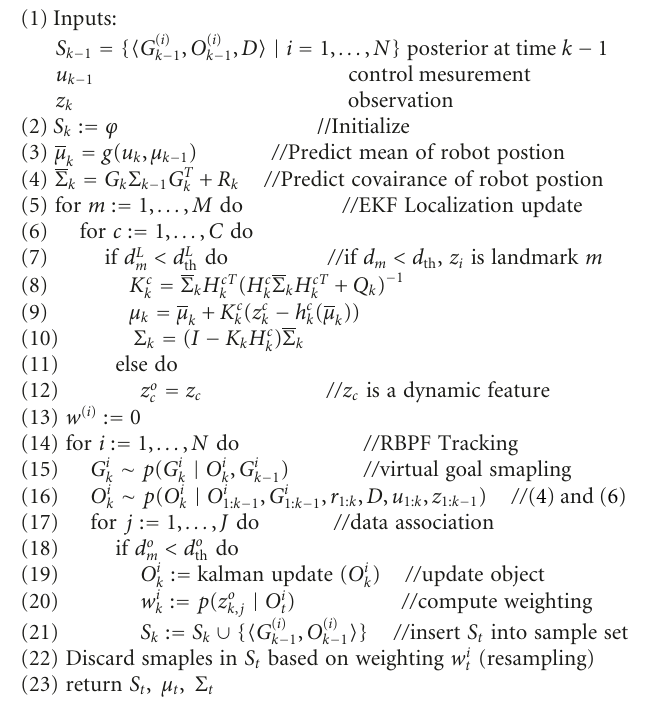
Algorithm 1: Localization and stream-based tracking algorithm.